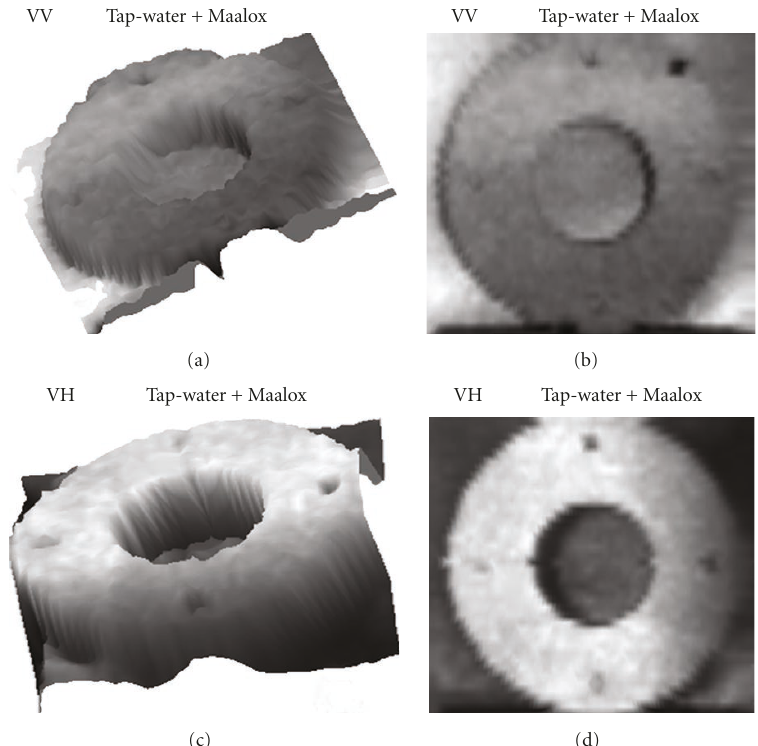
Figure 15: Underwater 3D images of a white-painted metallic disc with slightly curvature and some holes, immersed in turbid water (27liters of tap water + 0.1ml of Maalox (cid:2) ) at a distance of 1.5m from receiver, obtained by AMULOR system equipped with VH and VV linear polarizer configurations and working at fixed modulation frequency ( f m =